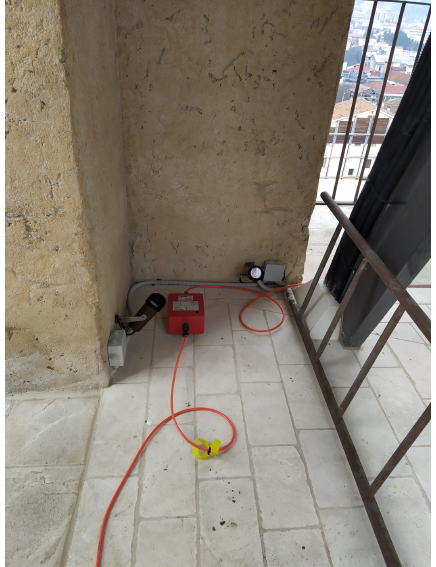
Figure 19. Accelerometer placed on the top of the bell tower, at the height of 22.03 m.